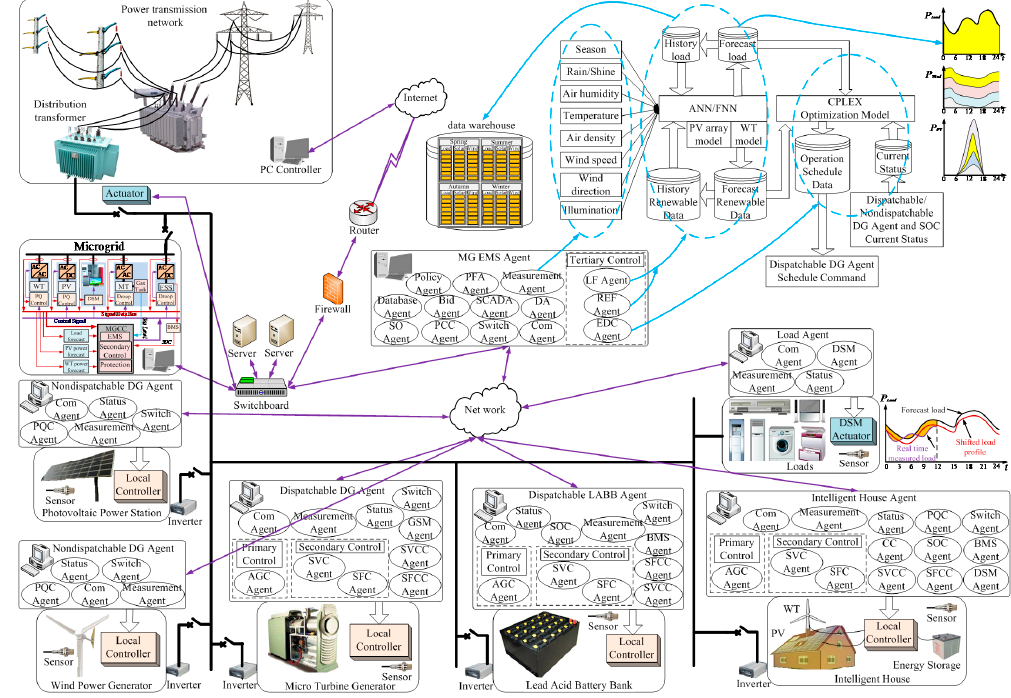
Figure 1. Multi agent based distributed smart micro grid (MG).